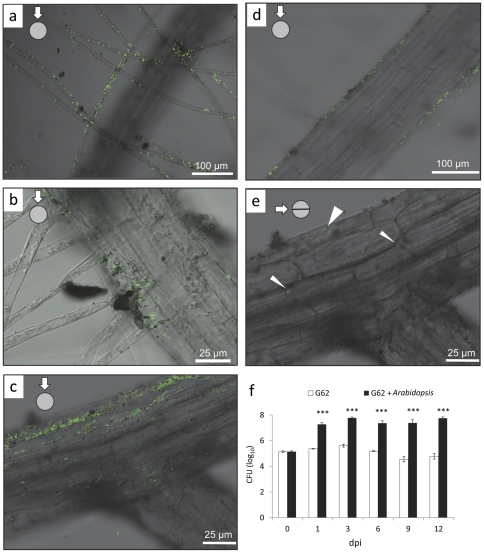
Colonization of Arabidopsis (Col-0) roots by P. sp. G62 after 3 days, visualized by eGFP - transformed bacteria.a–d: colonization of root hairs and root surface 3 days after inoculation of the root with bacteria, photographs of the root surface. e: sporadic bacteria inside of roots: focus at the middle of the root as can be seen by the focused xylem strand; thin arrows: single bacteria inside of the root, thick arrow: bacterium at root surface. f: cfu (colony forming units) of bacteria in liquid plant medium with or without plants (dpi: days post inoculation). Mean values ± SE, asterisks indicate p-values (***: p<0.001).